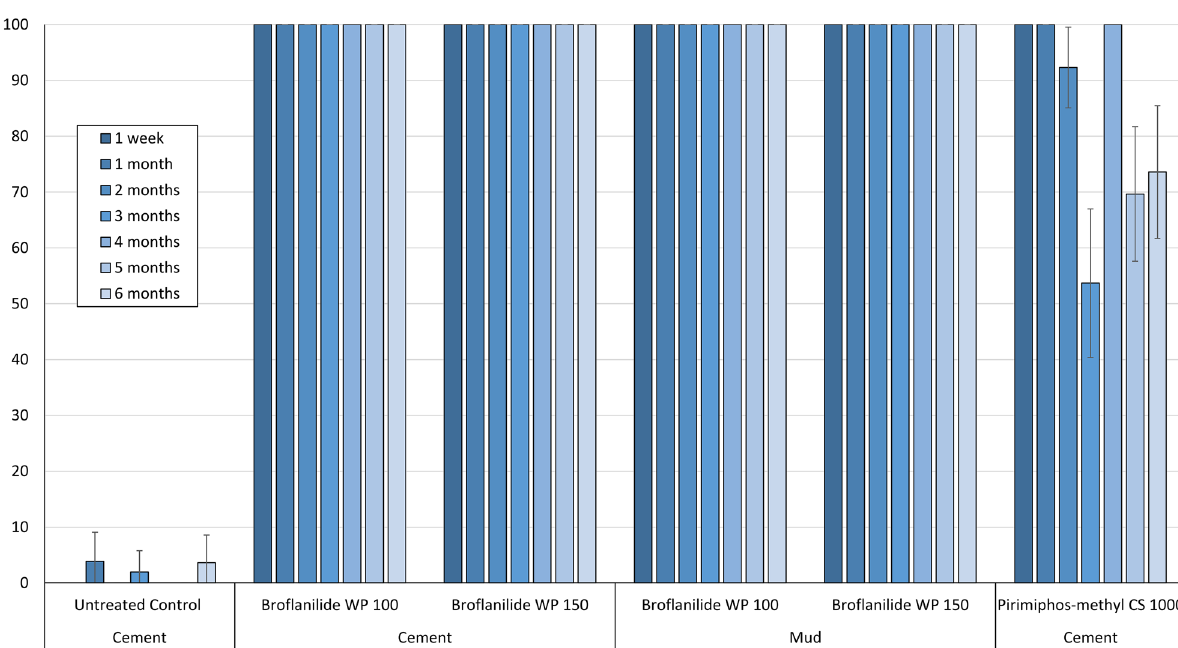
Figure 7. Cone bioassays mortality (72 h) with pyrethroid-resistant An. gambiae sl Covè on Broflanilide WP-treated experimental hut walls. At each monthly interval, ~ 50 2–5 days old female mosquitoes were exposed on treated walls of each hut in cohorts of 10 per cone. Error bars represent 95% confidence